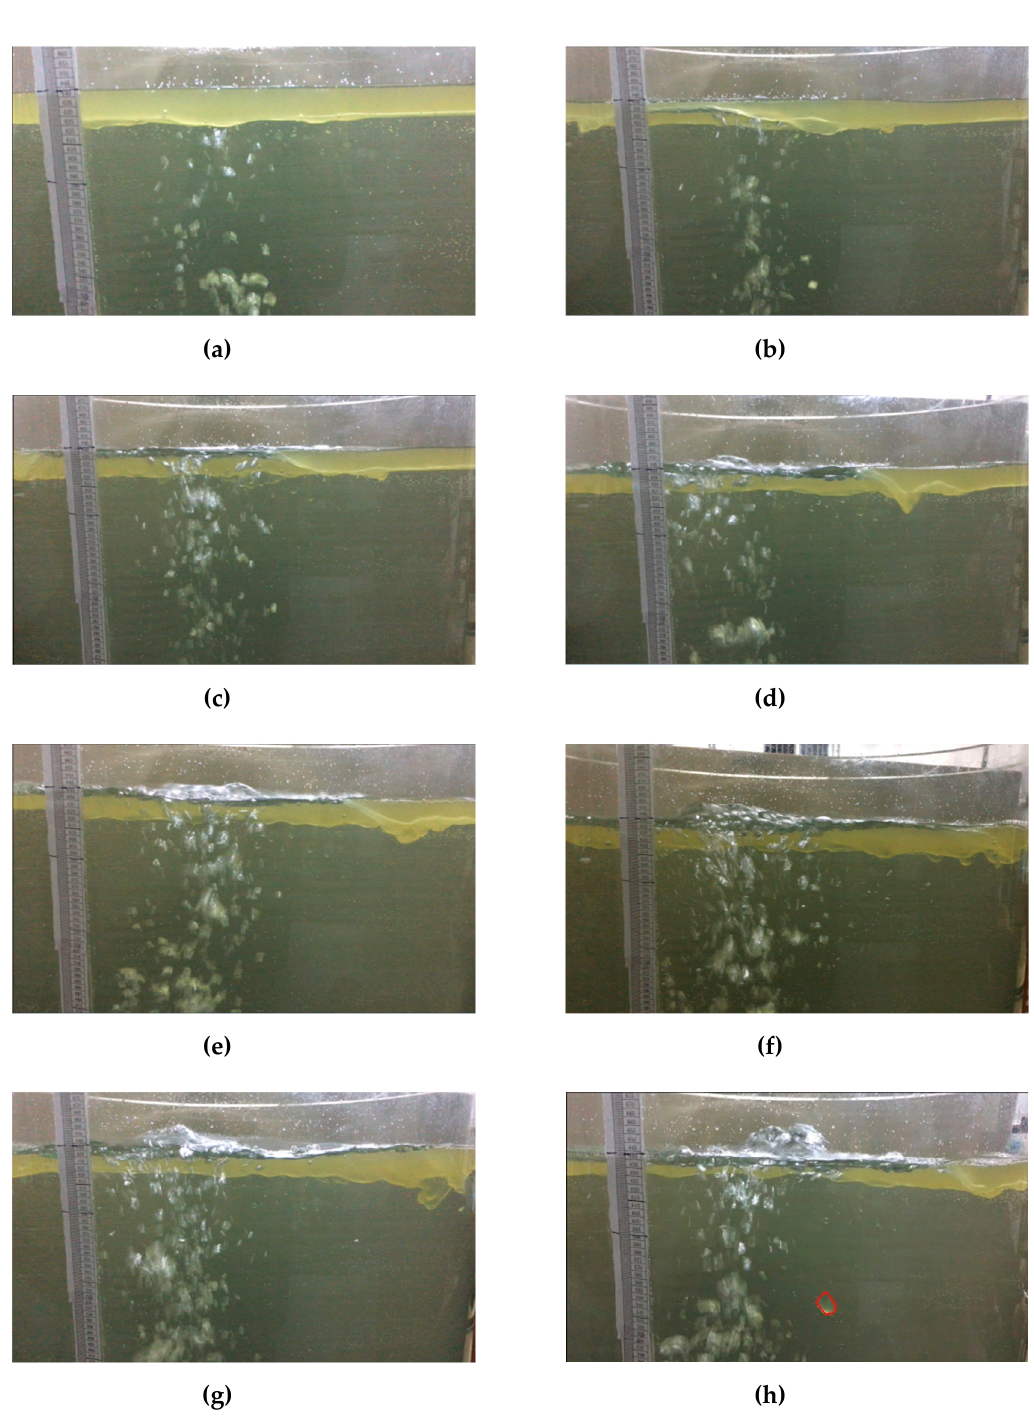
Figure 5. The influence of the air flow rate to the entrapment in the water model simulating the ladle with a single porous plug and OLT of 14 mm: ( a ) Q = 0.0475 m 3 /h; ( b ) Q = 0.095 m 3 /h; ( c ) Q = 0.143 m 3 /h; ( d ) Q = 0.191 m 3 /h; ( e ) Q = 0.238 m 3 /h; ( f ) Q = 0.286 m 3 /h; ( g ) Q = 0.333 m 3 /h; ( h ) Q = 0.381 m 3 /h.